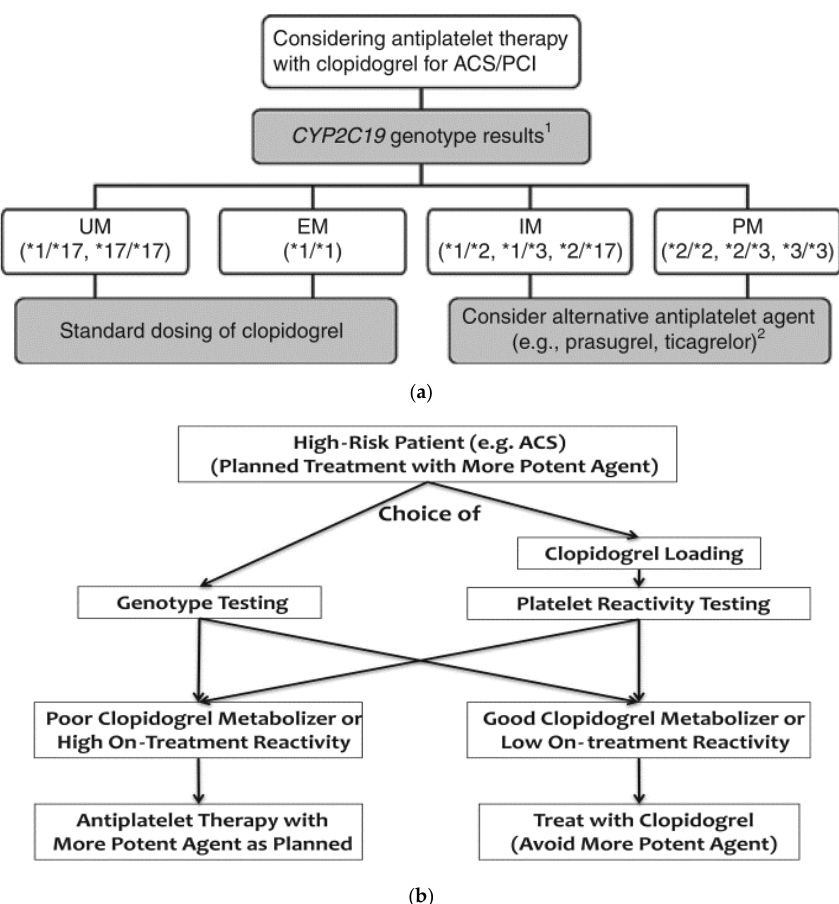
Figure 5 . Proposed Clinical Algorithms for Tailoring Clopidogrel Therapy. Proposed clinical algorithms for tailoring clopidogrel therapy based on CYP2C19 genotype ( a , b ) or on-treatment platelet reactivity ( b ). The algorithms do not account for non-genetic or other precision medicine regulators of clopidogrel resistance. 1 Only the most common CYP2C19 genotypes are illustrated; 2 Prasugrel and